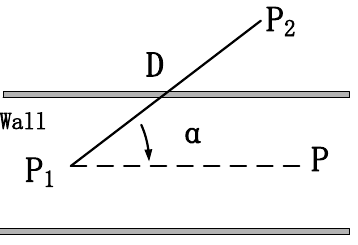
Figure 7. Trajectory intersects with a